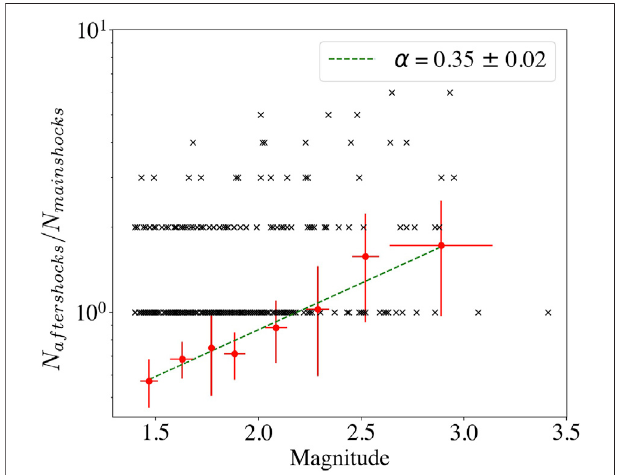
FIGURE 8 | Average number of triggered events as a function of the magnitude of the trigger over magnitude bins of size δ m ≥ 0.15, which increases as ≈ 10 α m .We fi nd α =0.35± 0.02for theKSMMAcatalog. Thered circles indicate the mean value over prescribed bins. The green dashed line indicates the productivity relation ≈ 10 α m fi tted to the data over the speci fi ed magnitude range. To fi nd α , we have also taken those events into account that did not trigger any